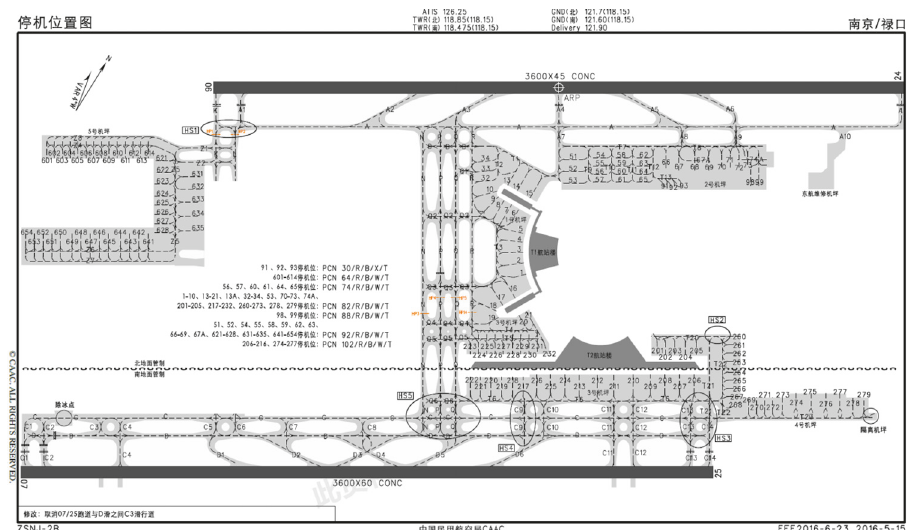
Figure 1: Nanjing Lukou International Airport layout.